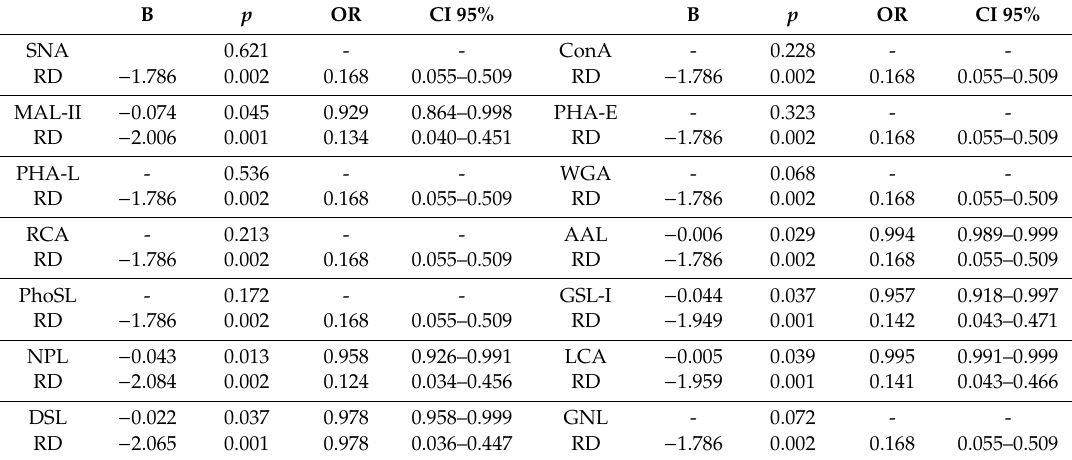
Table 5. Multivariate binary logistic regression analysis for the evaluation of the relationship between ultrafiltration rate and lectins adjusted for residual diuresis, with values obtained for PD samples.